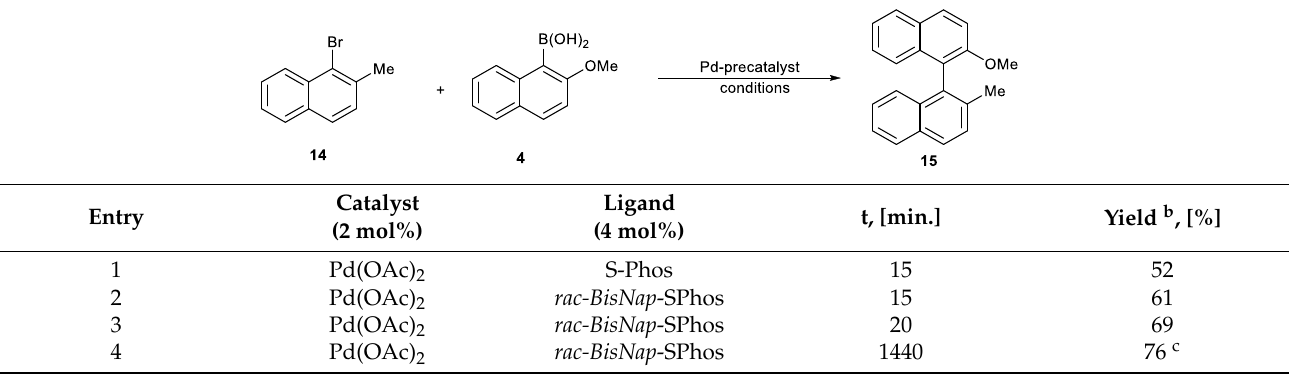
Table 4. Synthesis of 2-methoxy- 2′ -methyl-1, 1′ -binaphthyl ( 15 ) under microwave conditions a .